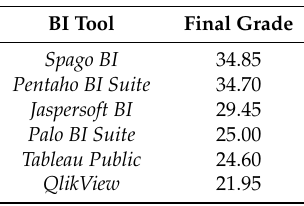
Table 3. Final rating assigned to each of the BI tools